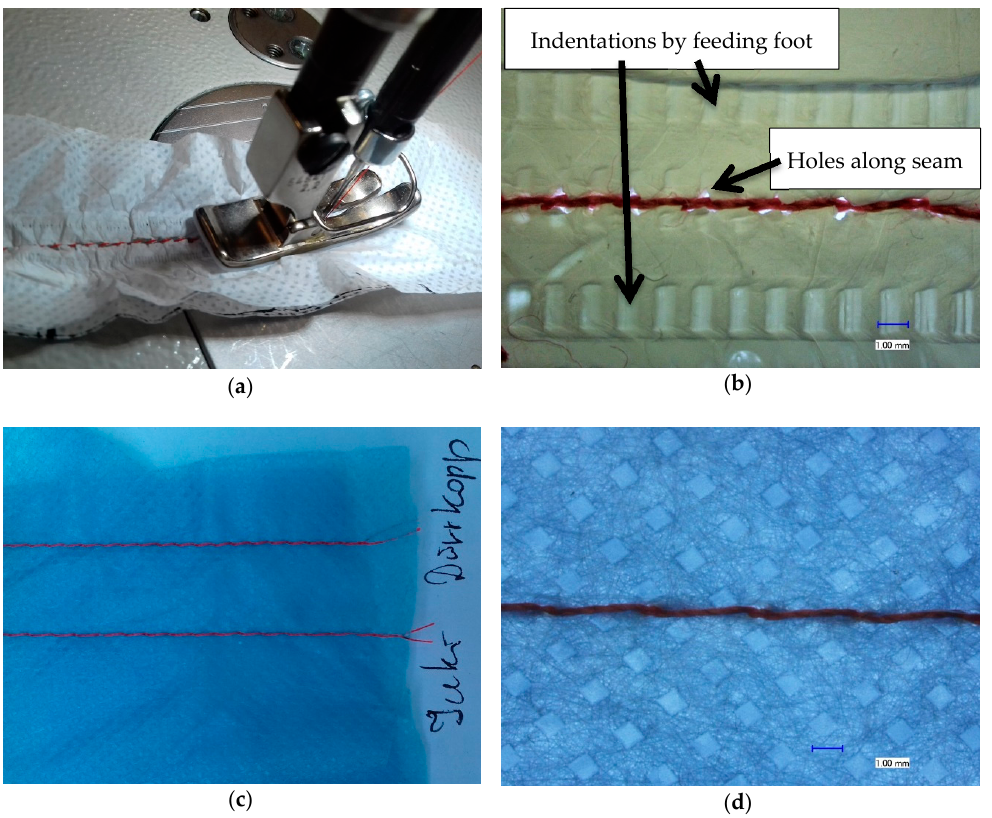
Figure 2. Examples of the sewing process: ( a ) Macroscopic depiction of the sewn nanofiber mats during sewing with Juki DDL-9000C Full Digital sewing machine; ( b ) Microscopic image of the seam and its environment; ( c ) Macroscopic depiction of the sewn substrate nonwoven; ( d ) microscopic image of a seam in the substrate nonwoven.